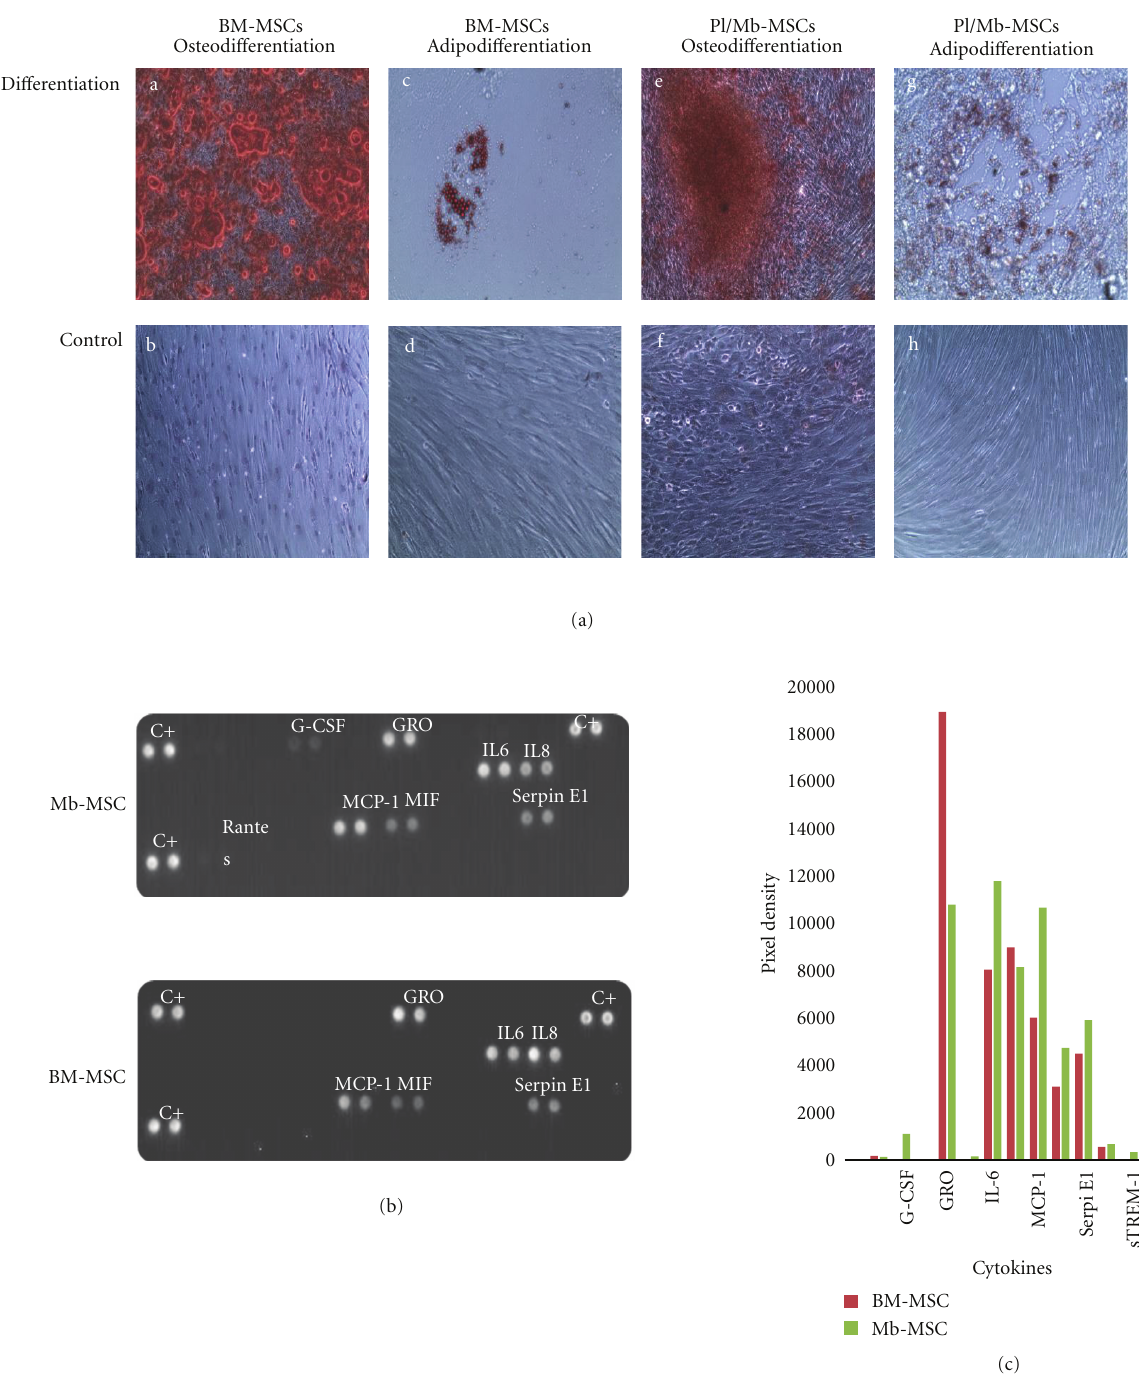
Figure 3: Di ff erentiation assay of Pl/Mb-MSCs in comparison to BM-MSCs and cytokines expression. (a) Representative di ff erentiation of Pl/Mb-MSCs passage 4 is shown. Cells were kept in induction medium (di ff erentiation) or control standard medium (control). (a–d) Osteogenic and adipocyte di ff erentiation and control for BM-MSCs. (f–h) Osteogenic and adipocyte di ff erentiation and control for Mb- MSCs. (b) Cytokine expressions of Mb-MSCs and BM-MSCs using the proteome profiler. (c) Quantification of cytokine optical density. Measurements were obtained with image J software